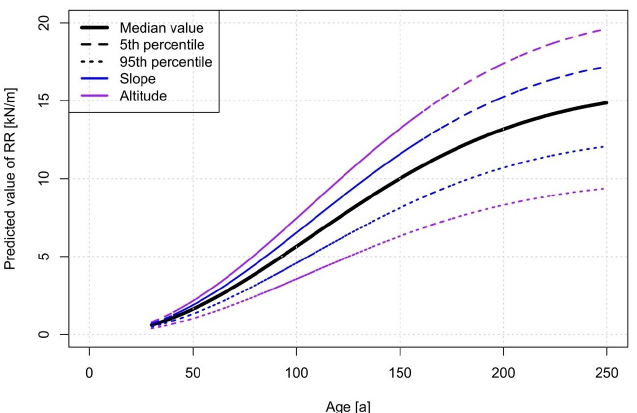
Figure 6. Sensitivity analysis of the different variables on the RR dynamics over time. The altitude has the highest influence on the